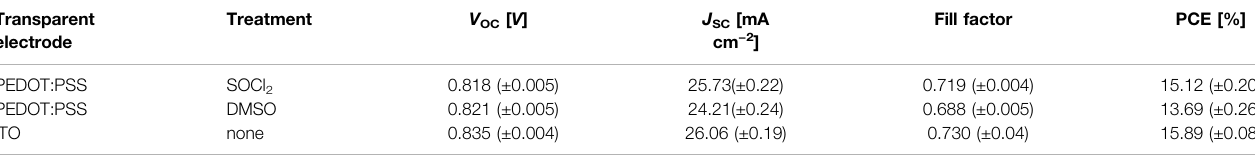
TABLE 1 | Photovoltaic parameters of fl exible OSCs based on PEDOT:PSS electrodes and rigid OSCs based on ITO electrodes. Transparent electrode